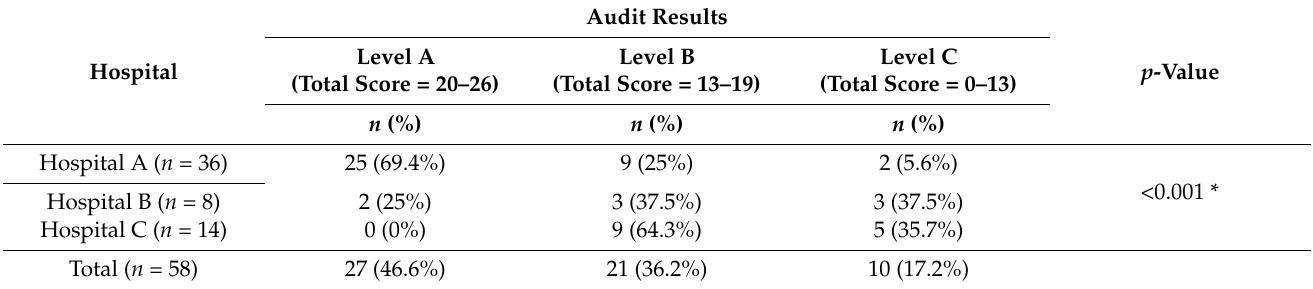
Table 4. Comparison of the audit results of the NCP documentation in three tertiary care hospitals in Riyadh.